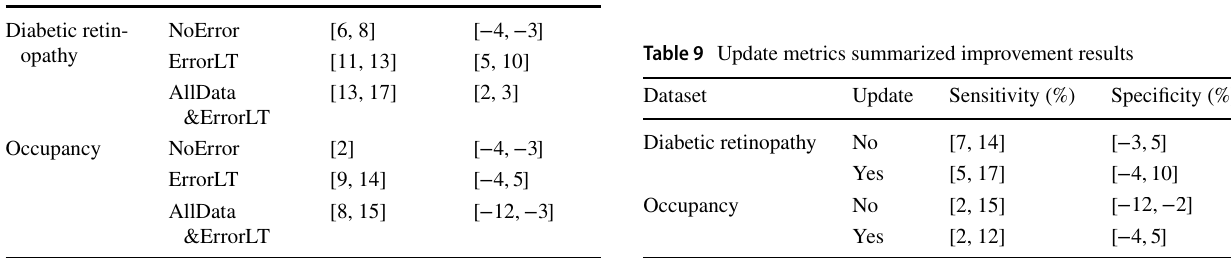
Table 7 Method summarized improvement results